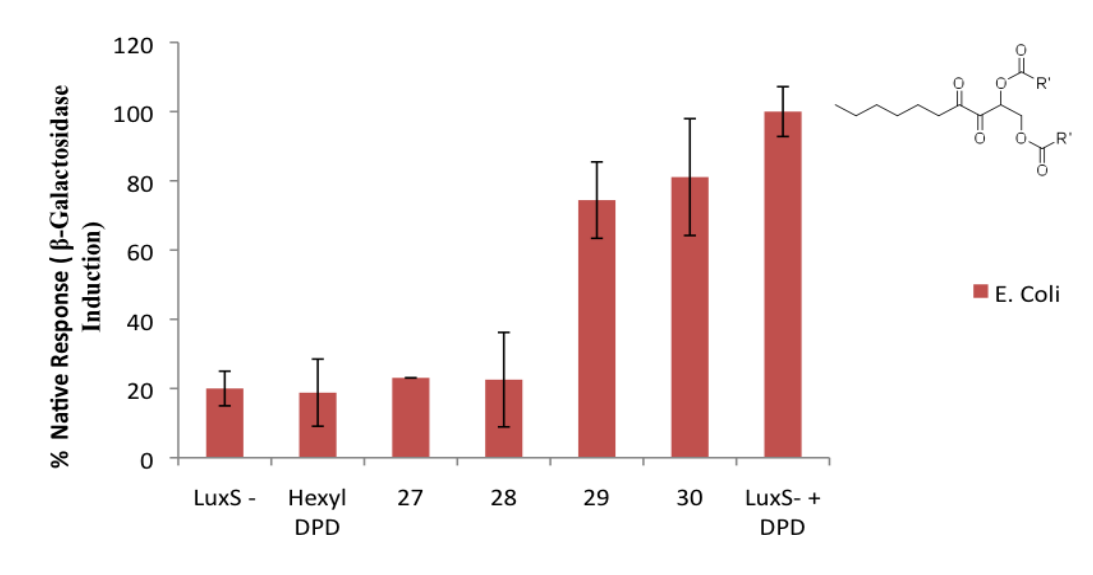
Figure 5. Inhibition of AI-2-mediated β-galactosidase expression in E . coli with various bis -ester analogs of hexyl DPD. [DPD] = 20  M, [analogs] = 20  M. Compounds 27 – 30 represent ester protected hexyl DPD analogs; 27 : hexyl DPD bis -methyl ester; 28 : hexyl DPD bis -propyl ester; 29 : hexyl DPD bis -butyl ester; 30 : hexyl DPD bis -pentyl ester.